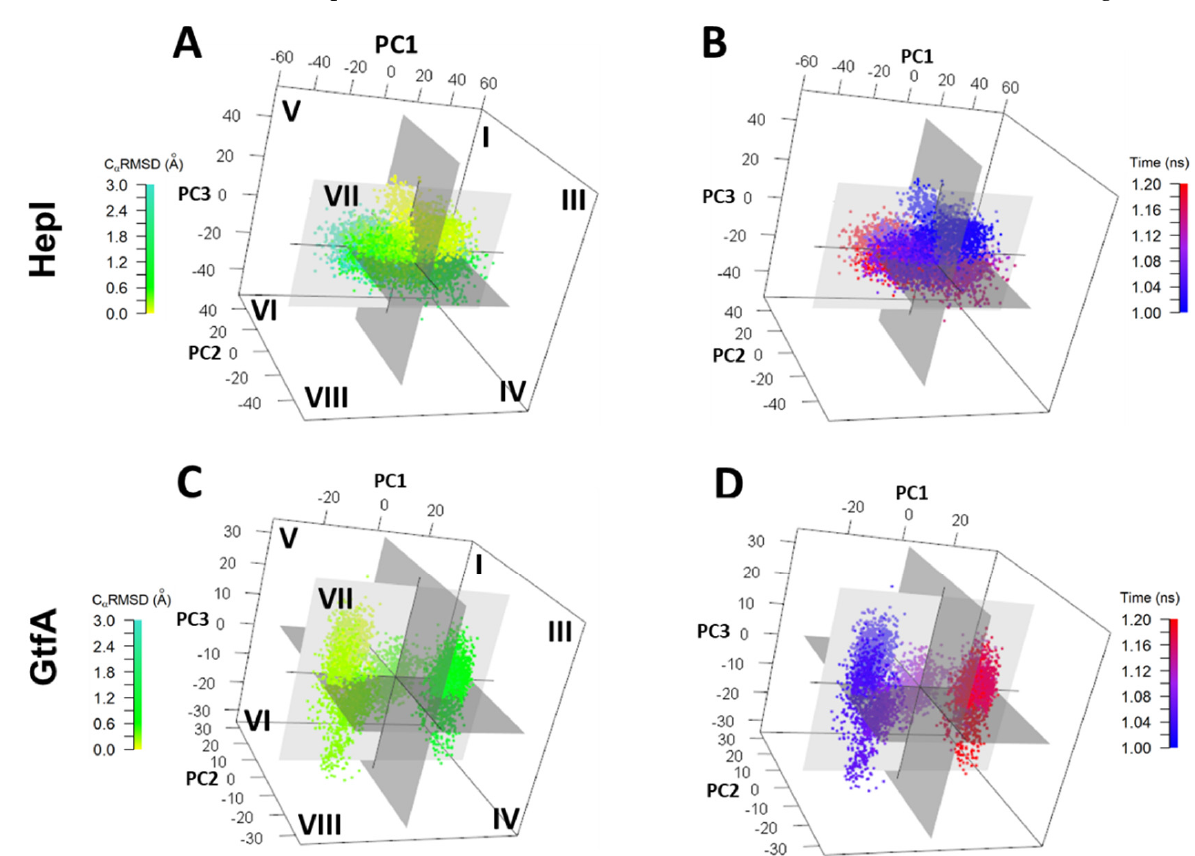
Figure 4. Conformation distribution of the top three principal components (3D-PCA) plotted against ( B , D ) C a RMSD (green to teal) and ( A , C ) time from 0.0 µs (blue) through 1.2 µs (red) for HepI (top) and Gtf A (bottom).